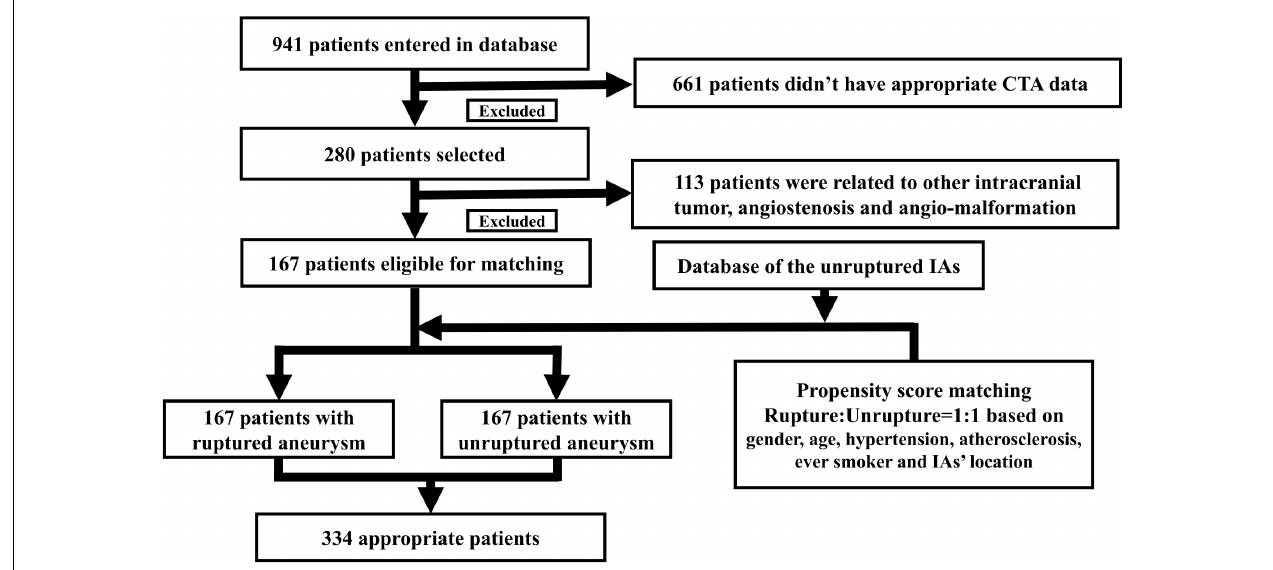
FIGURE 2 | The selecting flow chart was presented here. A total of 941 patients were enrolled into our study. 167 patients with ruptured IA met our standards in our series. Another 167 patients with unruptured IA were then selected using the propensity score matching. The matching process yielded 167 patients in each group.